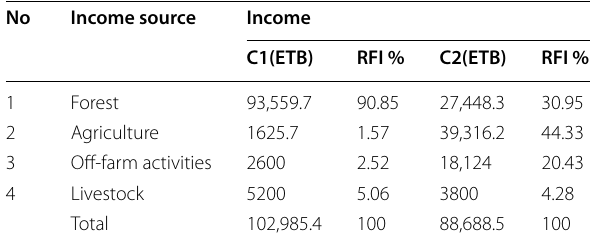
Table 4 Annual average and relative income (%) from non- forest product Income from